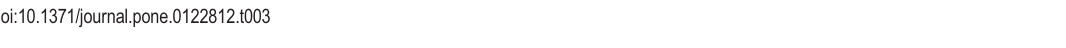
The table structure of the input data in the SNPer database can be retrieved by sql command (DESCRIBE < table_name >